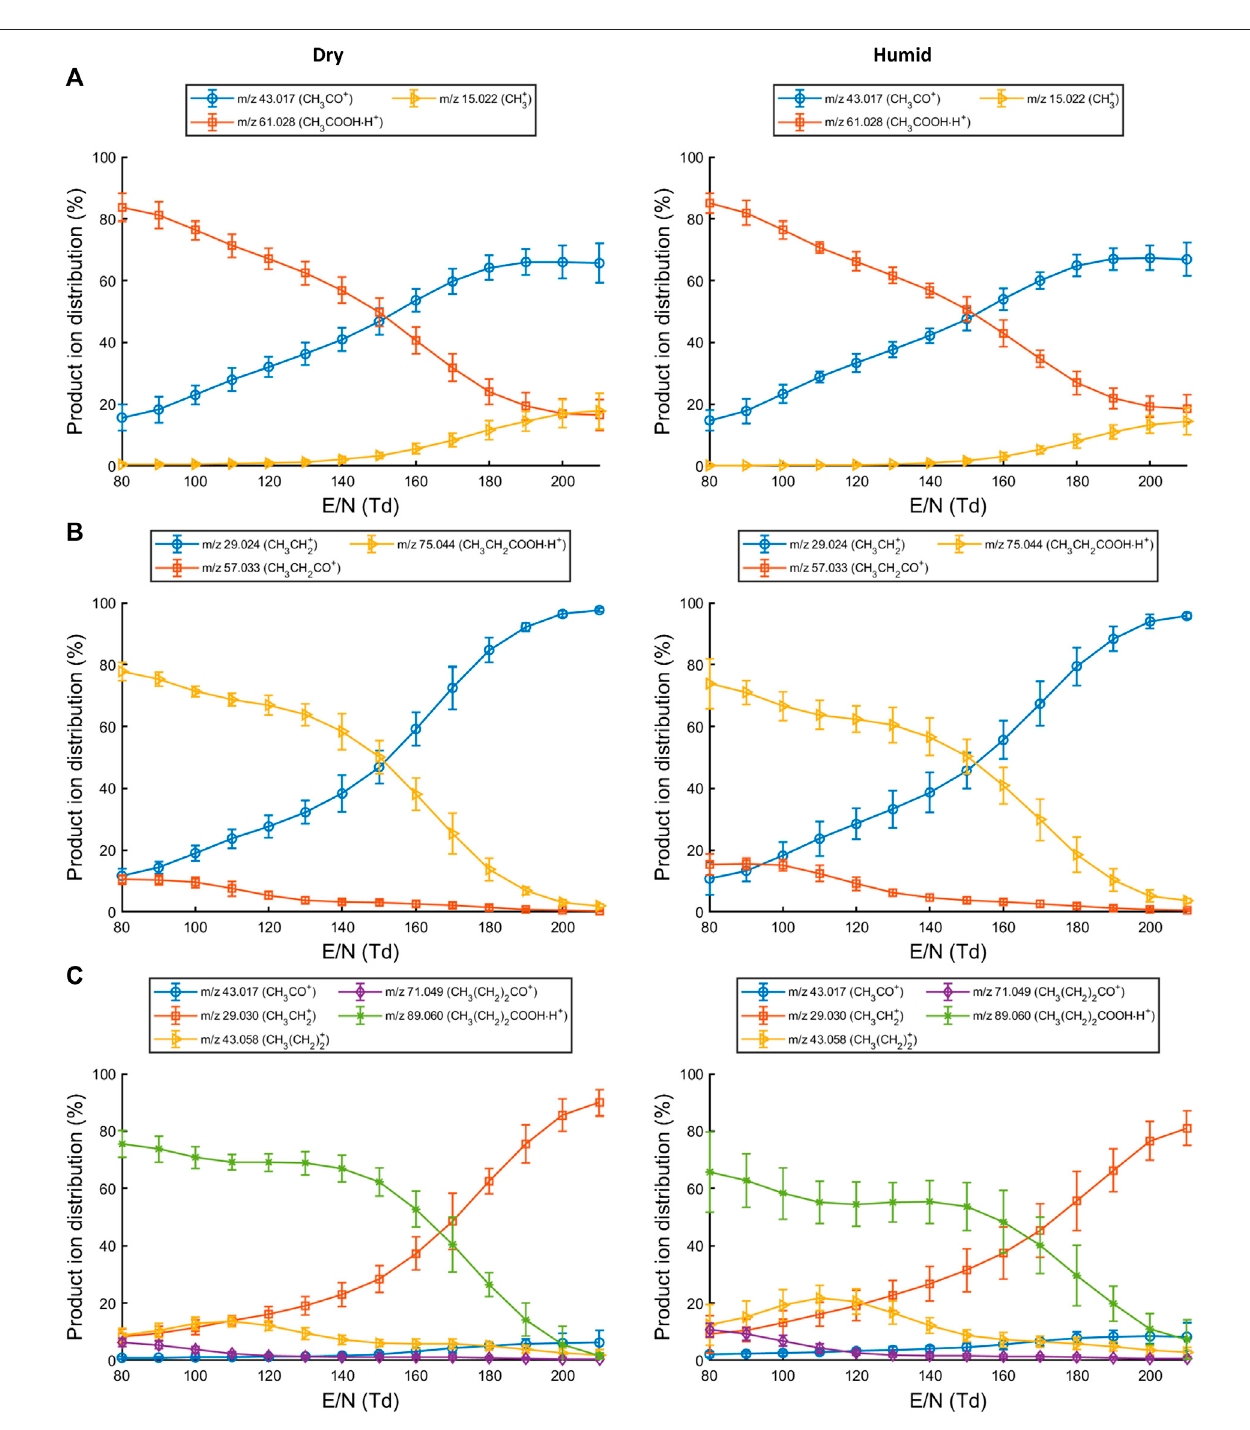
FIGURE 1 | Production ion distributions for reactions of (A) acetic acid, (B) propionic acid and (C) butyric acid with H3O+ in the drift tube at different reduced electric fi elds. Error bars represent three standard deviations.